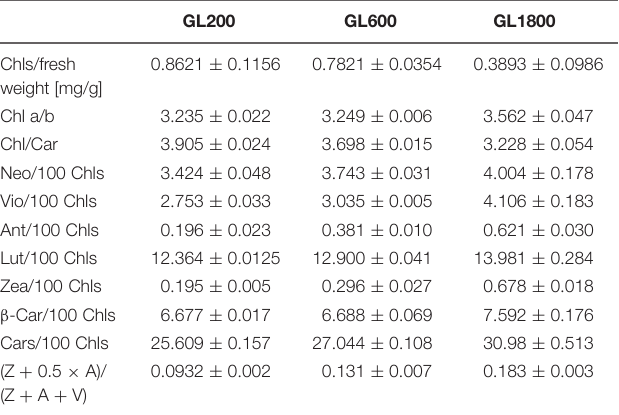
TABLE 1 | Pigment analysis of plants grown under different light